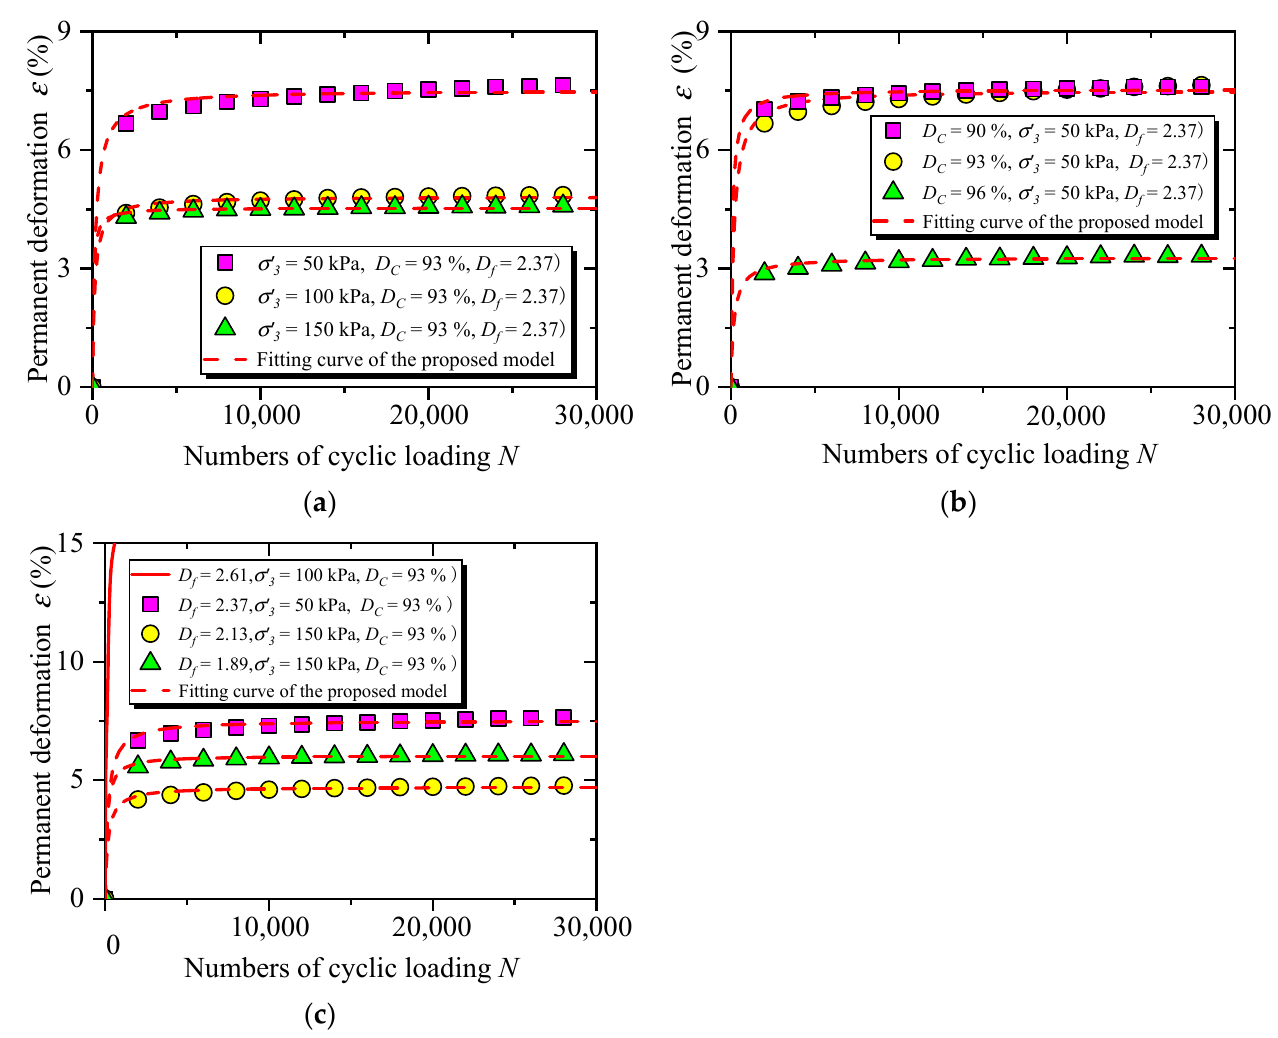
Figure 12. Comparison between the proposed model and the test curve: ( a ) under di ff erent con fi ning pressure conditions, ( b ) under diverse compaction degree conditions, and ( c ) under various grading conditions. Table 3. Parameters of the proposed model.